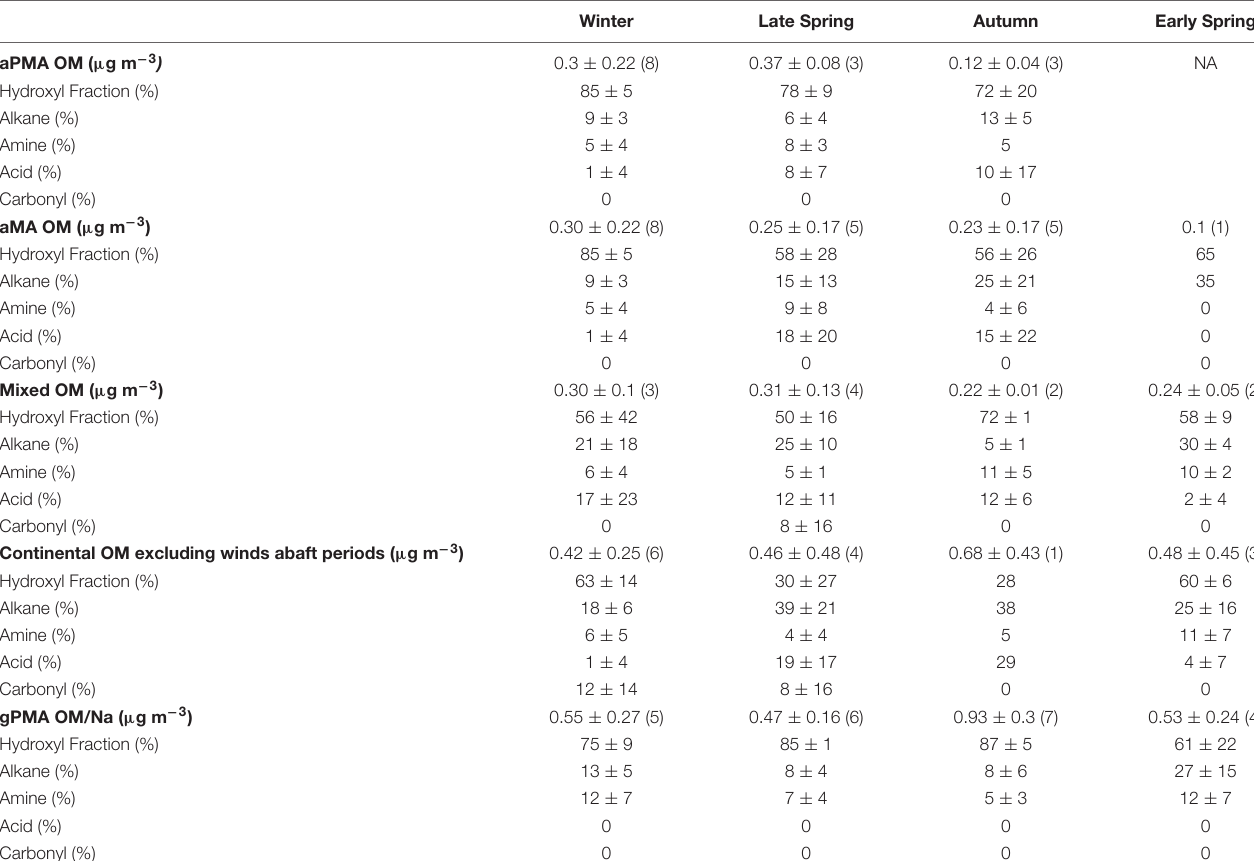
TABLE 1 | Average organic functional group composition and organic mass (OM) averages of < 1 µ m filters from four different air mass categories during the four NAAMES